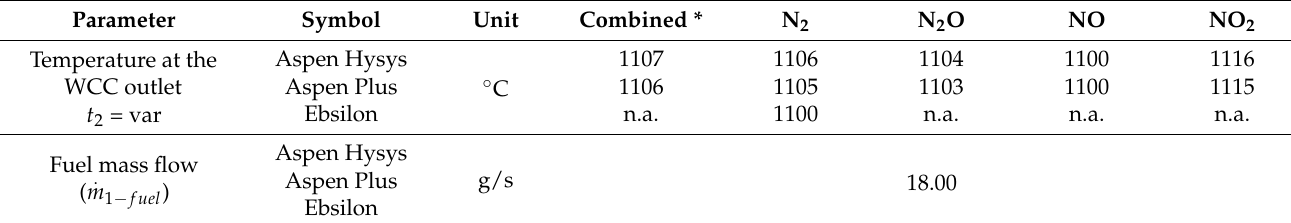
Table 11. 18 g/s mixture 1 (syngas) with NH 3 combustion to NO, NO 2 , N 2 , N 2 O under stoichiometric conditions (100 g/s